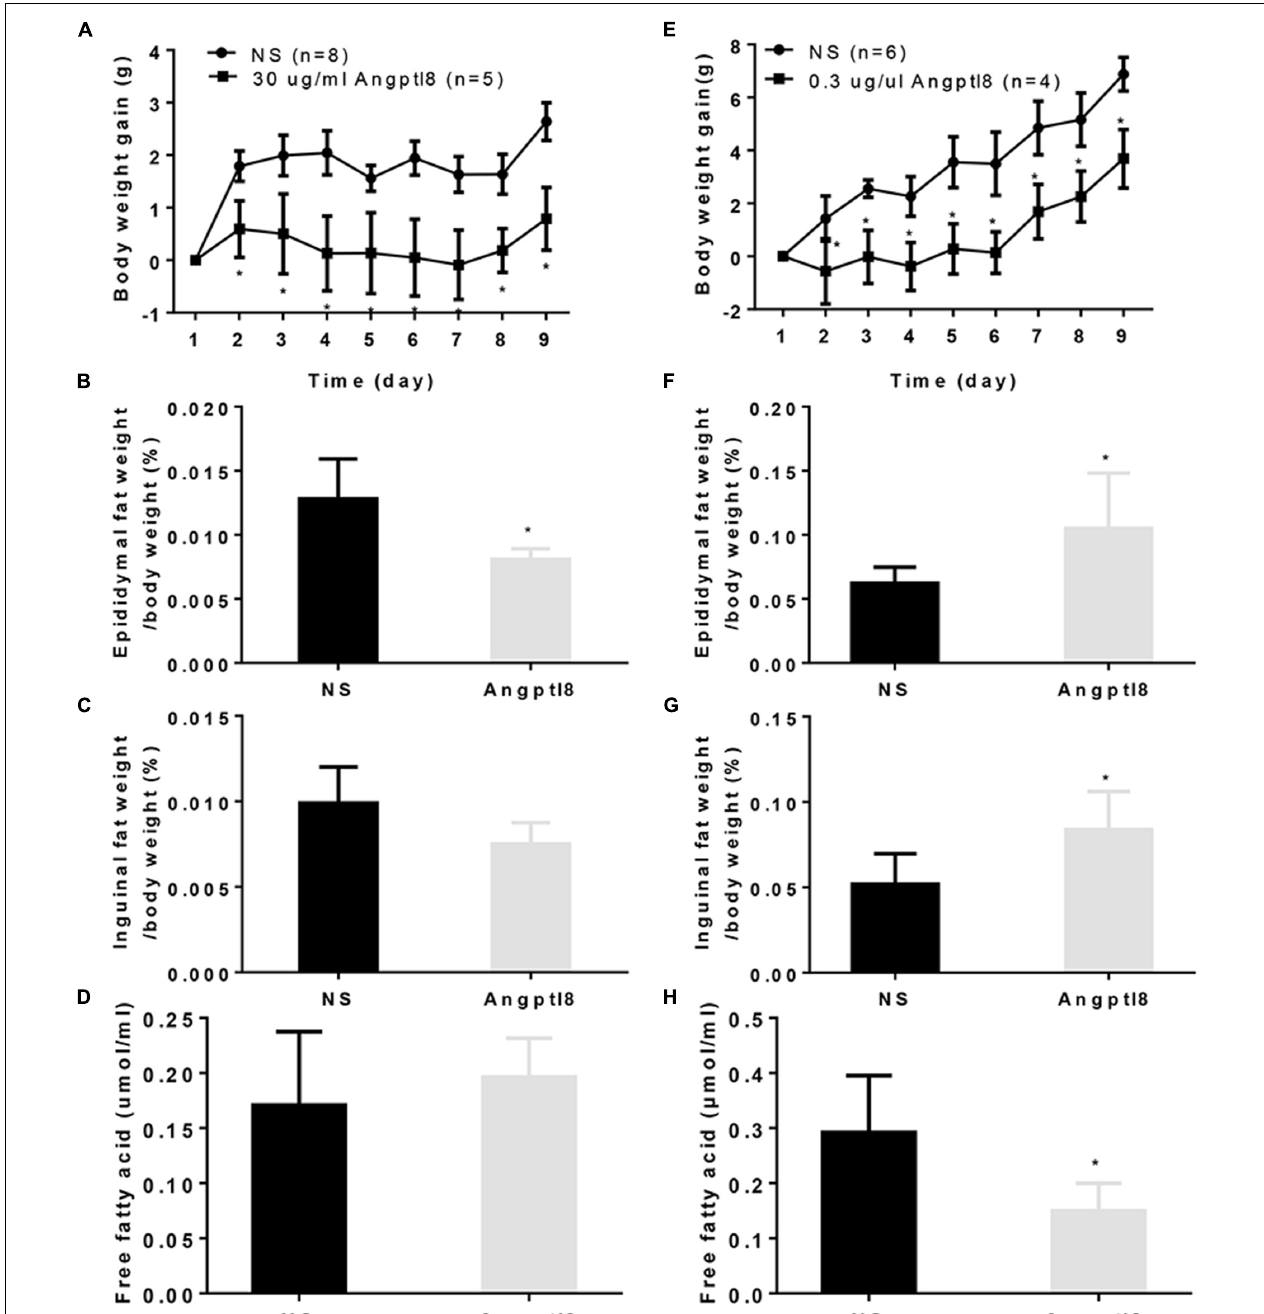
FIGURE 6 | Effect of peripheral and central Angptl8 on body weight gain, fat mass and plasma FFA levels. Angptl8 (30 µ g/ml) via I.V. injection decreased 9-day body weight gain (A) and epididymal fat deposits (B) but had no effect on inguinal fat deposits (C) or plasma free fatty acid levels (D) . Angptl8 (0.3 µ g/ µ l) via I.C.V. injection decreased 9-day body weight gain (E) and plasma free fatty acid (H) but increased the epididymal (F) and inguinal (G) fat deposits. Data are means ± SEM. ∗ P < 0.05 relative to the NS control group.